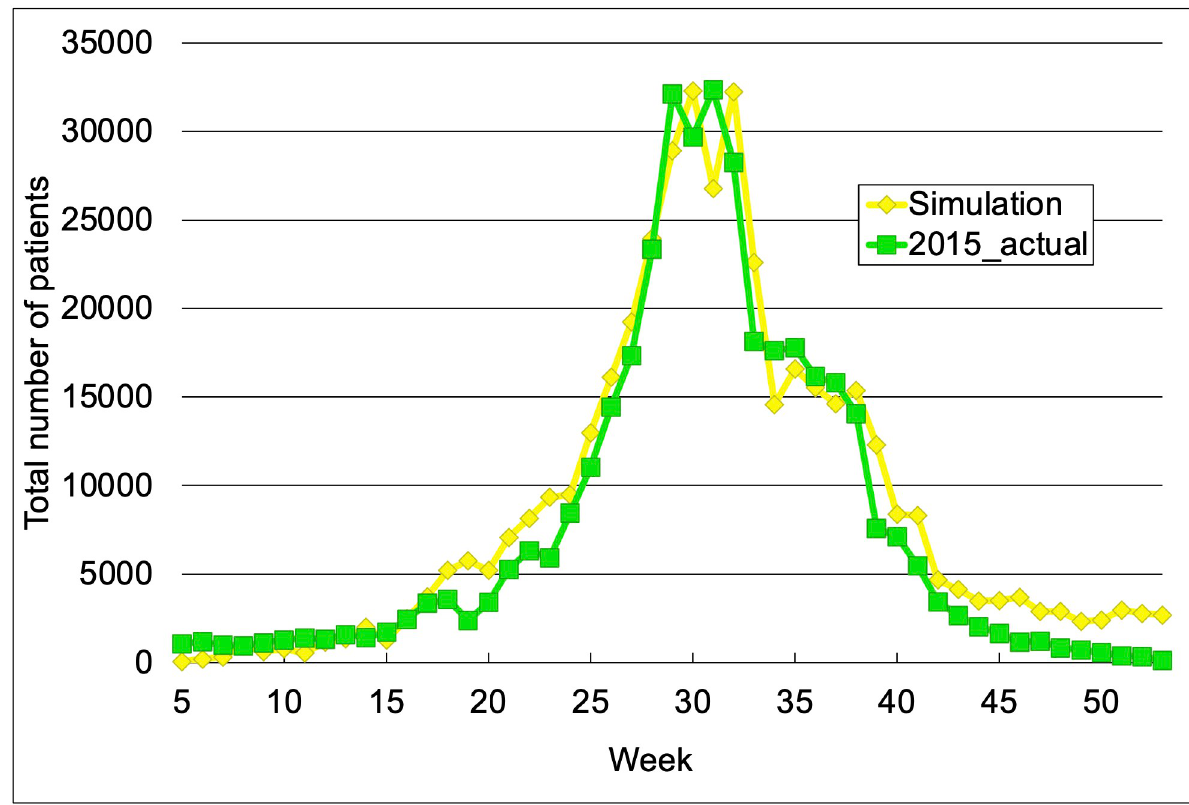
Fig 2. Simulation result of HFMD epidemic in 2015 (using 5 weeks of data as input). The maximum and minimum output values were adjusted to the maximum and minimum number of patients in 2015, respectively.